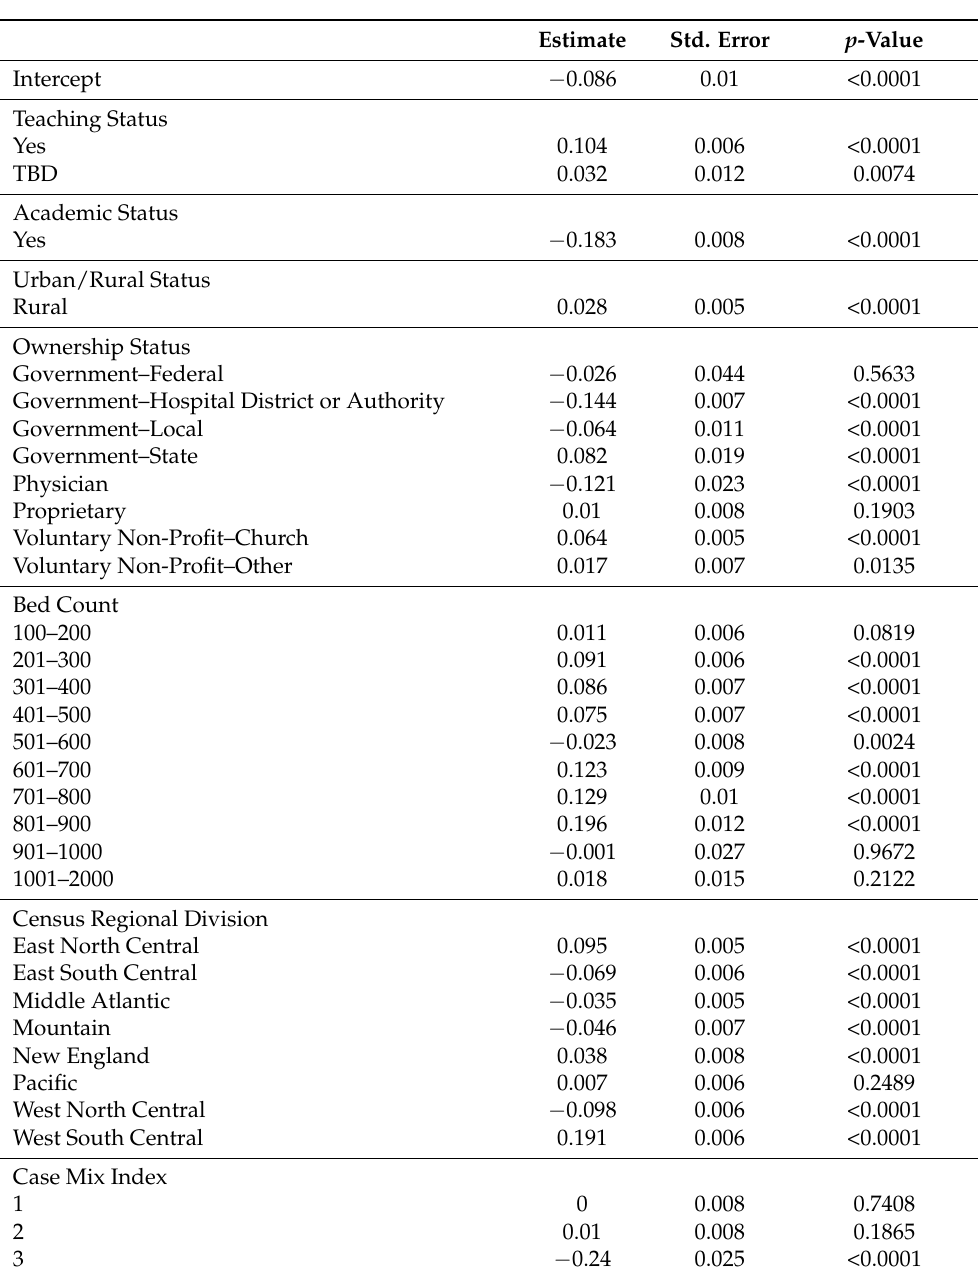
Table 3. Summary of the multivariate linear regression between excess coding intensity and facility